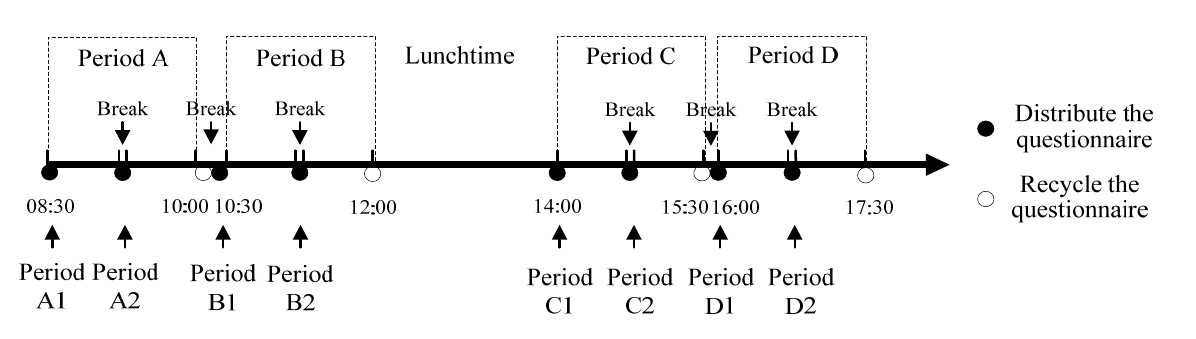
Figure 4. Subjective survey design.